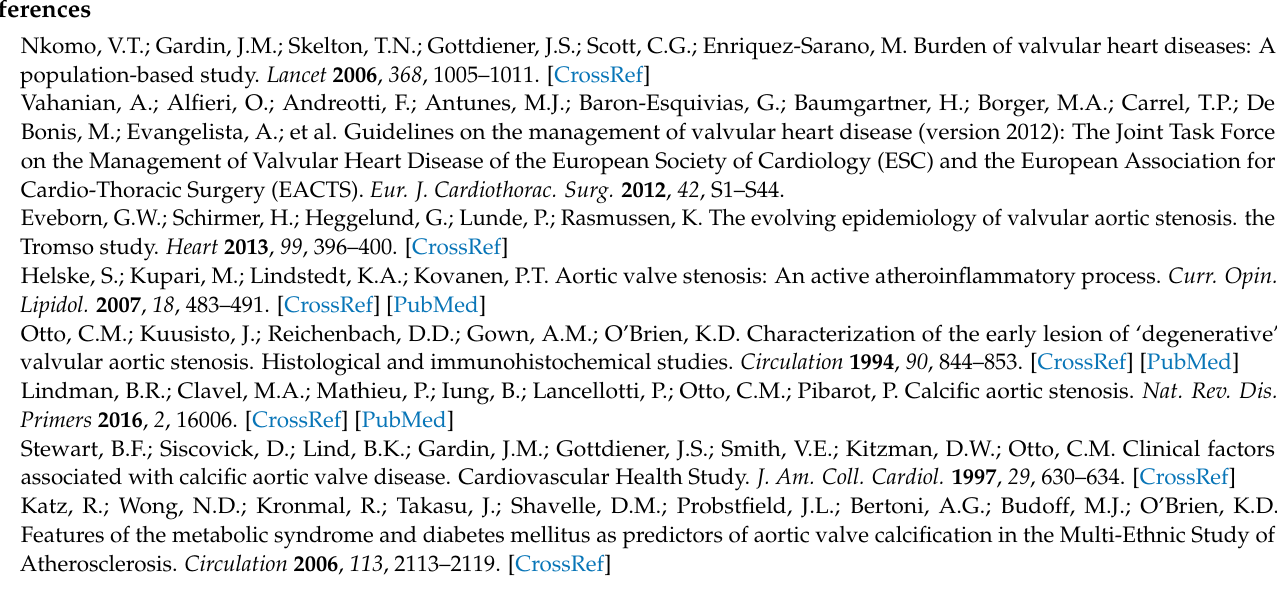
Lp(a) levels, Table S3: Pathways description and log10(p) from the MCODE algorithm analysis of the top genes identified in the transcriptomic stud. Figure S1: Molecular Complex Detection (MCODE) algorithm network performed for the top genes influenced by Lp(a) levels. MCODE algorithm detects densely connected regions in large protein-protein interaction networks that may represent molecular complexes. MCODE details are represented in Table